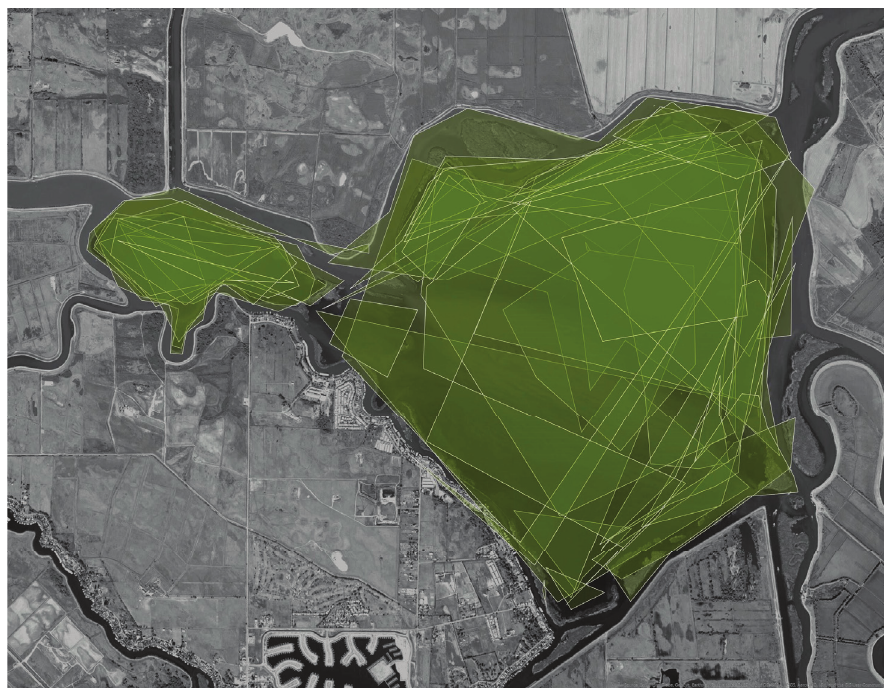
Figure 11. Where are desired sites for public access? What would you like to see? Results indicate that public access points are desired throughout Franks Tract, especially on the Bethel Island shoreline on Franks Tract’s West side. Common types of access included non-motorized and motorized launch sites as well as general public access to the water, which is non-existent currently. Contradictory opinions were presented at a later design workshop by Bethel Island residents and business owners.